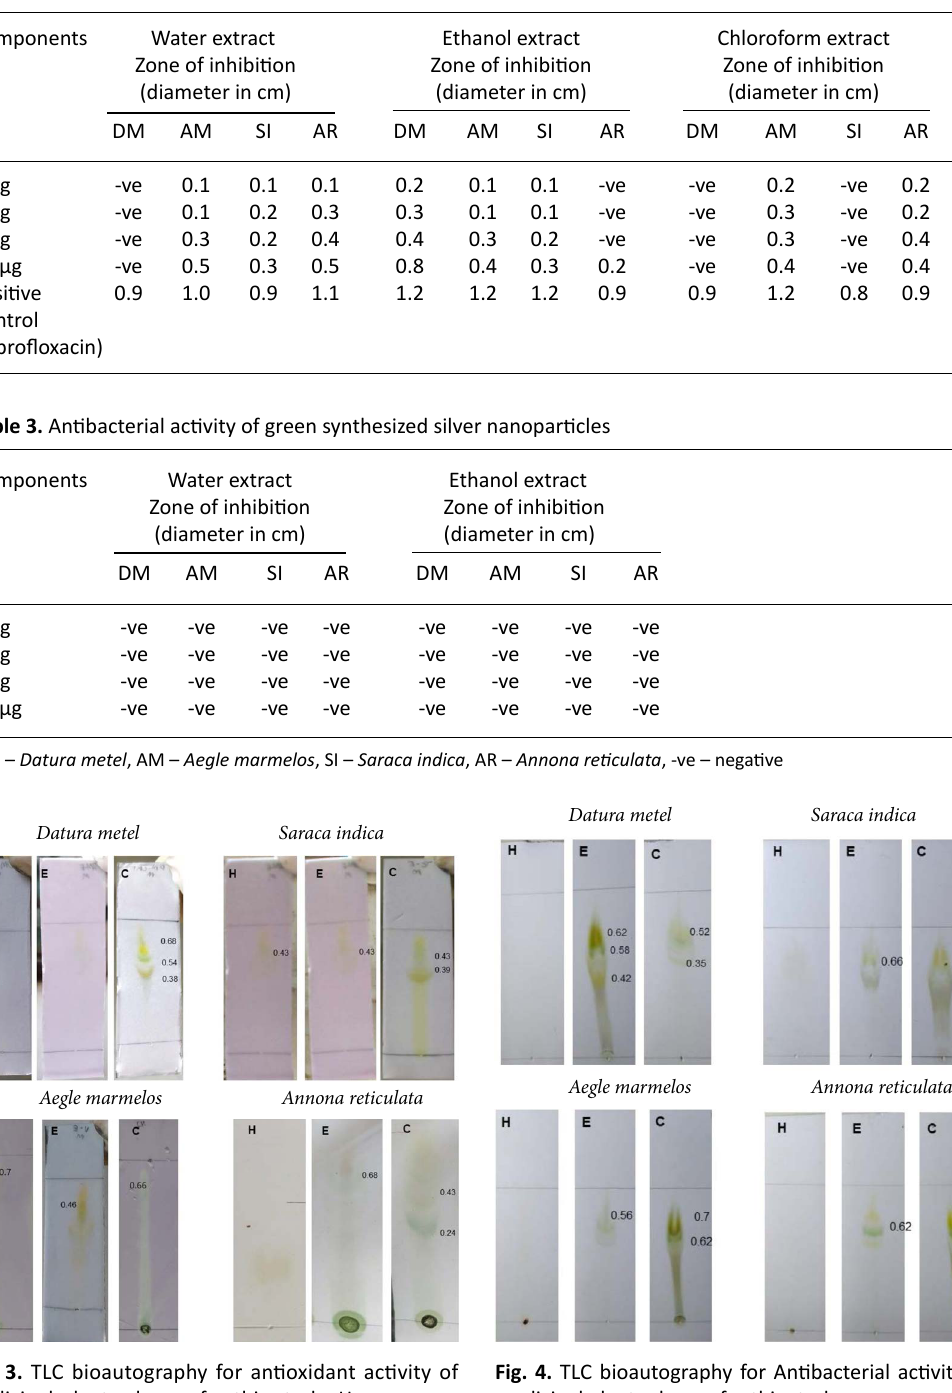
Table 2. Antibacterial activity of various extracts Components